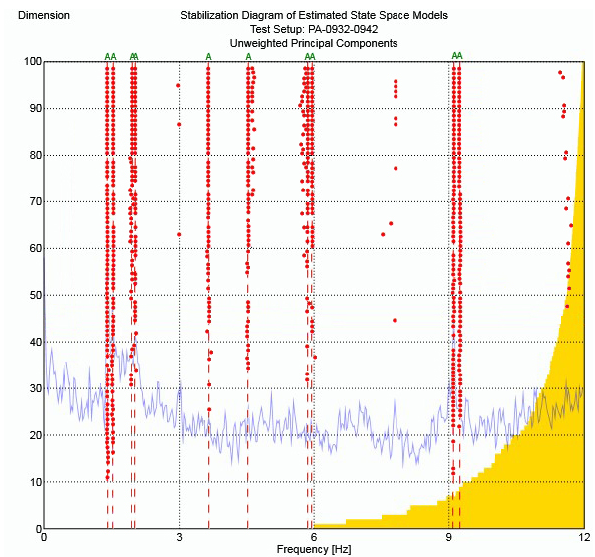
Figure 6. Stabilization diagram of the wind turbine under parked conditions (PA), with a rotor speed of 0rpm (revolutions per